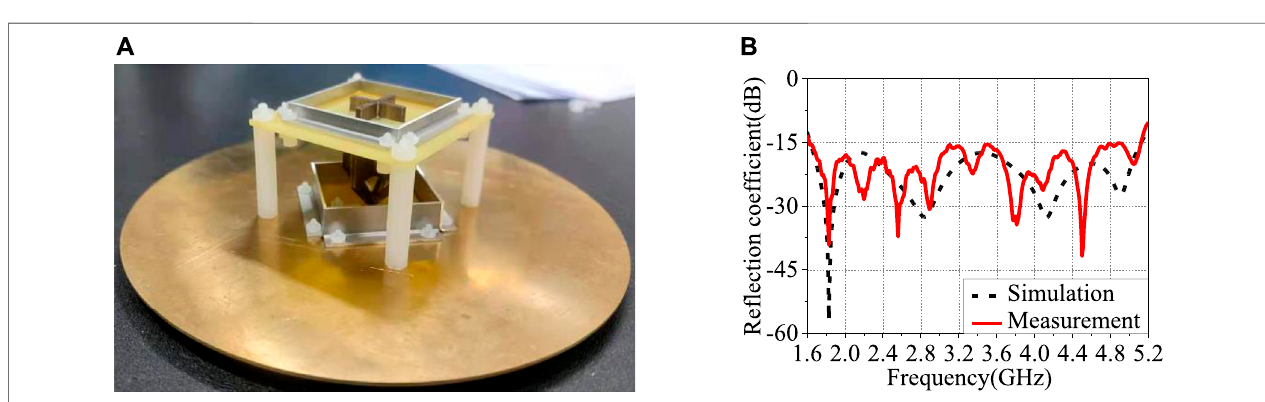
FIGURE 8 | (A) Photograph and (B) measured re fl ection coef fi cients of the proposed antenna.